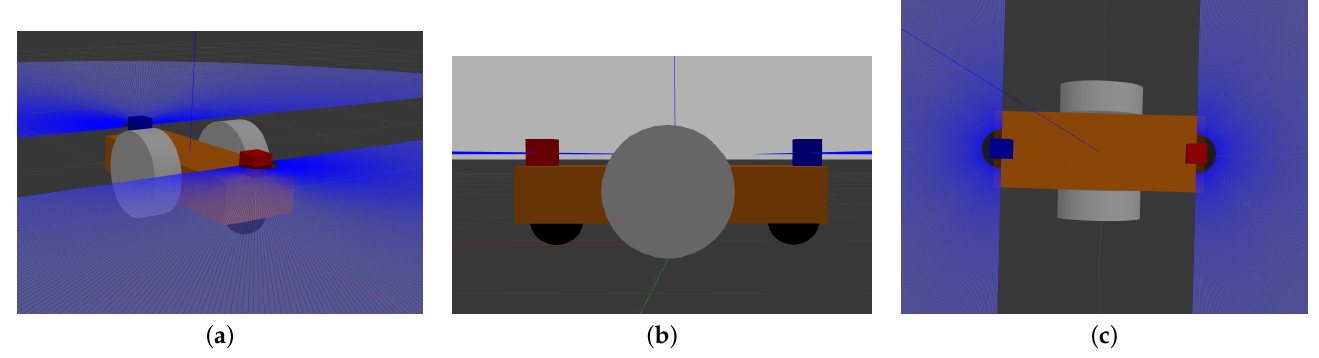
Figure 13. The simulated robot: the white wheels are the differential wheels, the black balls are the caster wheels and the blue/red boxes are the LiDARs. Note that the blue rays depict the LiDAR measurements. ( a ) General view; ( b ) Side view; ( c ) Top